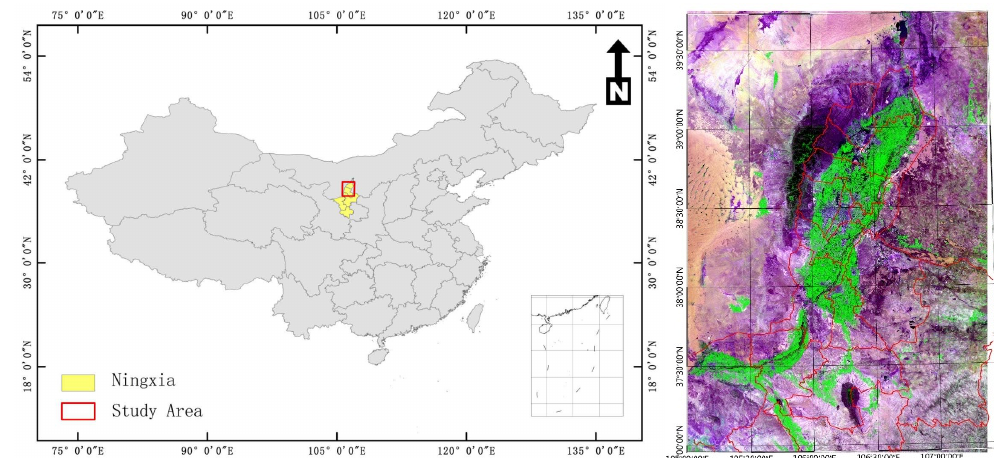
Figure 1. The S2 composite image of the study area showing the landscape and its geographical location in China.